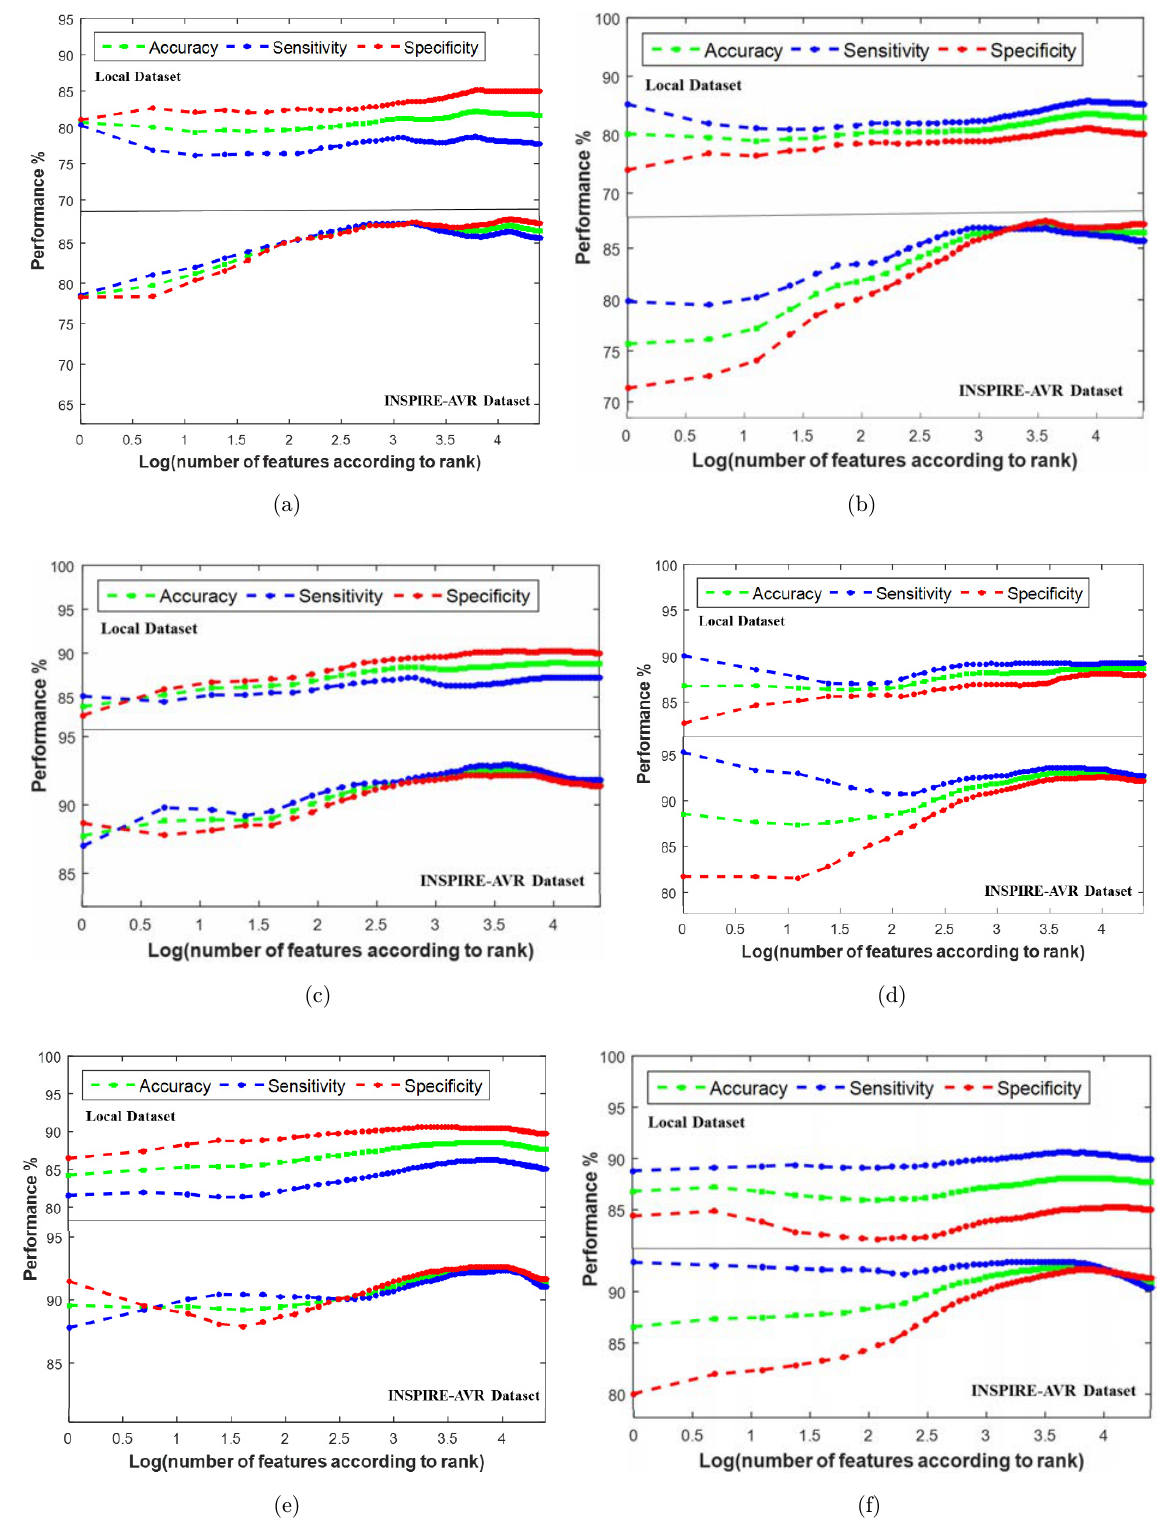
Fig. 15. Performance metrics (Green, Blue and Red curves depicting Accuracy, Sensitivity and Speci¯city, respectively) for di®erent-ranked feature subsets, upper curves: Local dataset and lower curves: INSPIRE-AVR dataset. (a), (c) and (e) Classi¯- cation performance of k -NN, SVM and Na ï ve Bayes classi¯er on features ranked by PCC and (b), (d) and (f) Classi¯cation performance of k -NN, SVM and Na ï ve Bayes classi¯er on features ranked by Relief-F